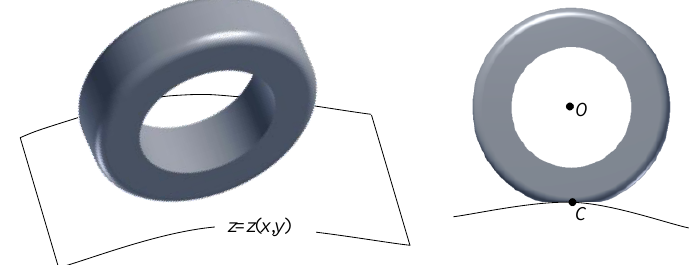
Figure 1. An example of a sketch of the contact point 𝐶 position on the road surface. According to the authors, locating this point is a complex task. When a vehicle moves over the road surface only a center position of a particular wheel is known (it results from geometrical parameters of a vehicle). The simplest way to find contact point 𝐶(𝑥 𝐶 , 𝑦 𝐶 , 𝑧 𝐶 ) is to assume that its coordinates are: 𝑥 𝐶 = 𝑥 𝑂 , 𝑦 𝐶 = 𝑦 𝑂 , 𝑧 𝐶 = 𝑧(𝑥 𝑂 , 𝑦 𝑂 ) . Such a situation is presented in Figure 2a.